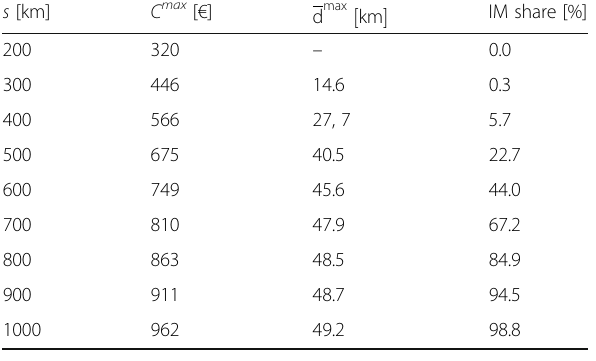
Table 5 Maximal average drayage distances d